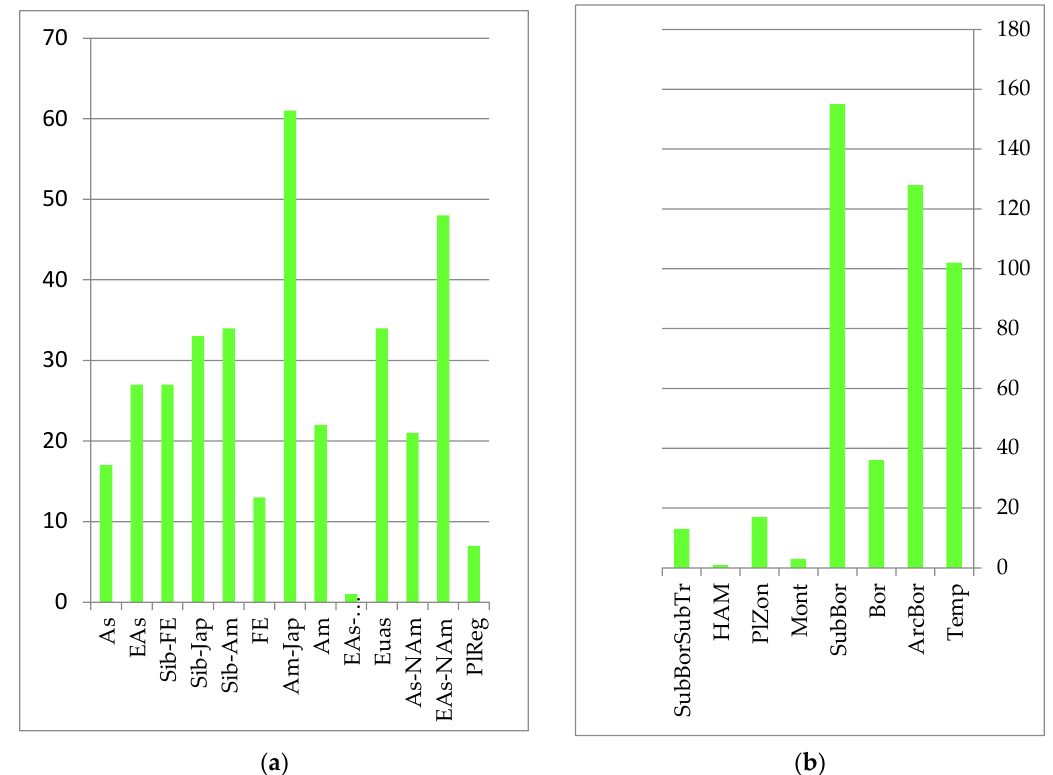
Figure 3. Number of species groups of the meadow floristics complex: ( a ) longitudinal species groups: Asian (As); Eastern Asian (EAs); Siberian–Far Eastern (Sib-FE); Siberian–Japanese (Sib- Jap); Siberian–Amurense (Sib-Am); Far Eastern (FE); Amurense–Japanese (Am-Jap); Amurense (Am); Eastern Asian–Paleotropical (EAs-PalTrp); Eurasian (Eas); Asian–North American (EAs-Nam); Eurasian–North American (Eas-NAm); PlReg–pluriregional; ( b ) zonal species groups: temperate (Temp); arcto–boreal (ArcBor); boreal (Bor); sub-boreal (SubBor); montane (Mont); plurizonal (PlZon); hypoarcto–montane (HAM); sub-boreal–sub-tropical (SubBorSubTr). Specific halophilic shortgrass meadows are common in the Amur Estuary, on the coast of the Tatar Strait and Sakhalin Bay. These meadows form a group of halophilic species, including Puccinellia phryganodes (Trin.) Scribn. et Merr., Triglochin asiatica (Kitag.) Á . Löve et D. Löve ( Triglochin maritima L.), Poa macrocalyx Trautv. et C.A. Mey., and Stellaria humifusa